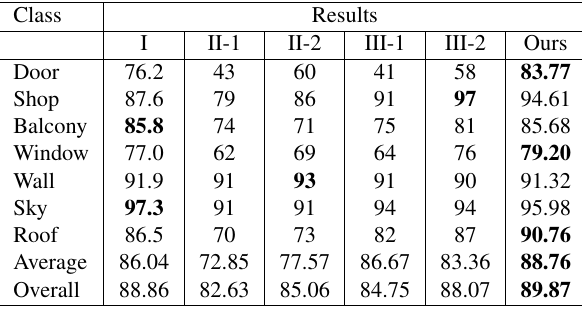
Figure 3. Qualitative results on the Graz dataset. The facade segments are homogeneous and nearly without noisy. Column (a) input images, (b) results from Structured Random Forest, (c) results after 10 iterations of the optimization algorithm mapped into the input image, (d) results after 50 iterations and (e) ground truth. Colors see Fig. 2.